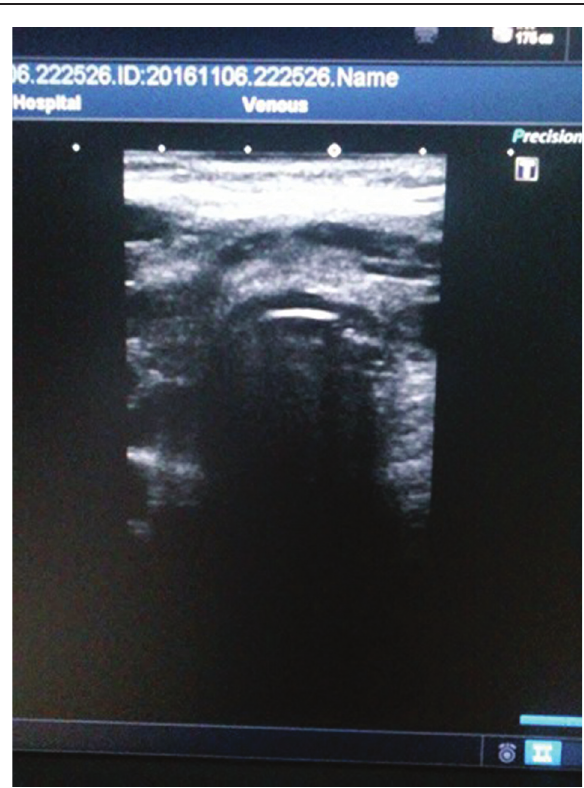
Ultrasonic image of correct endotracheal intubation.